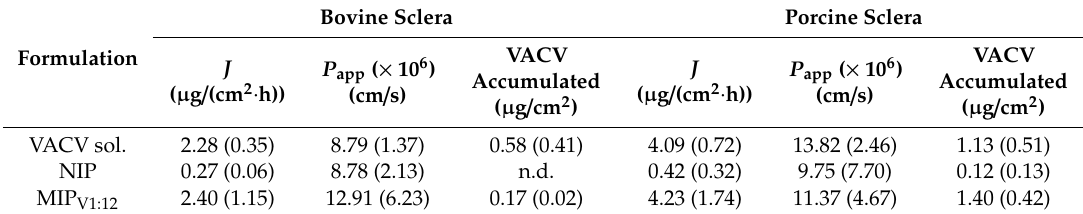
Table 3. Flux ( J ), permeability coe ffi cient ( P app ), and drug accumulated in bovine and porcine sclera when VACV was applied as a solution or as VACV-loaded NIP and MIP V1:12 hydrogels. Mean values ( n = 3) and error bars indicate standard deviations; n.d. means non-quantifiable values. Bovine Formulation